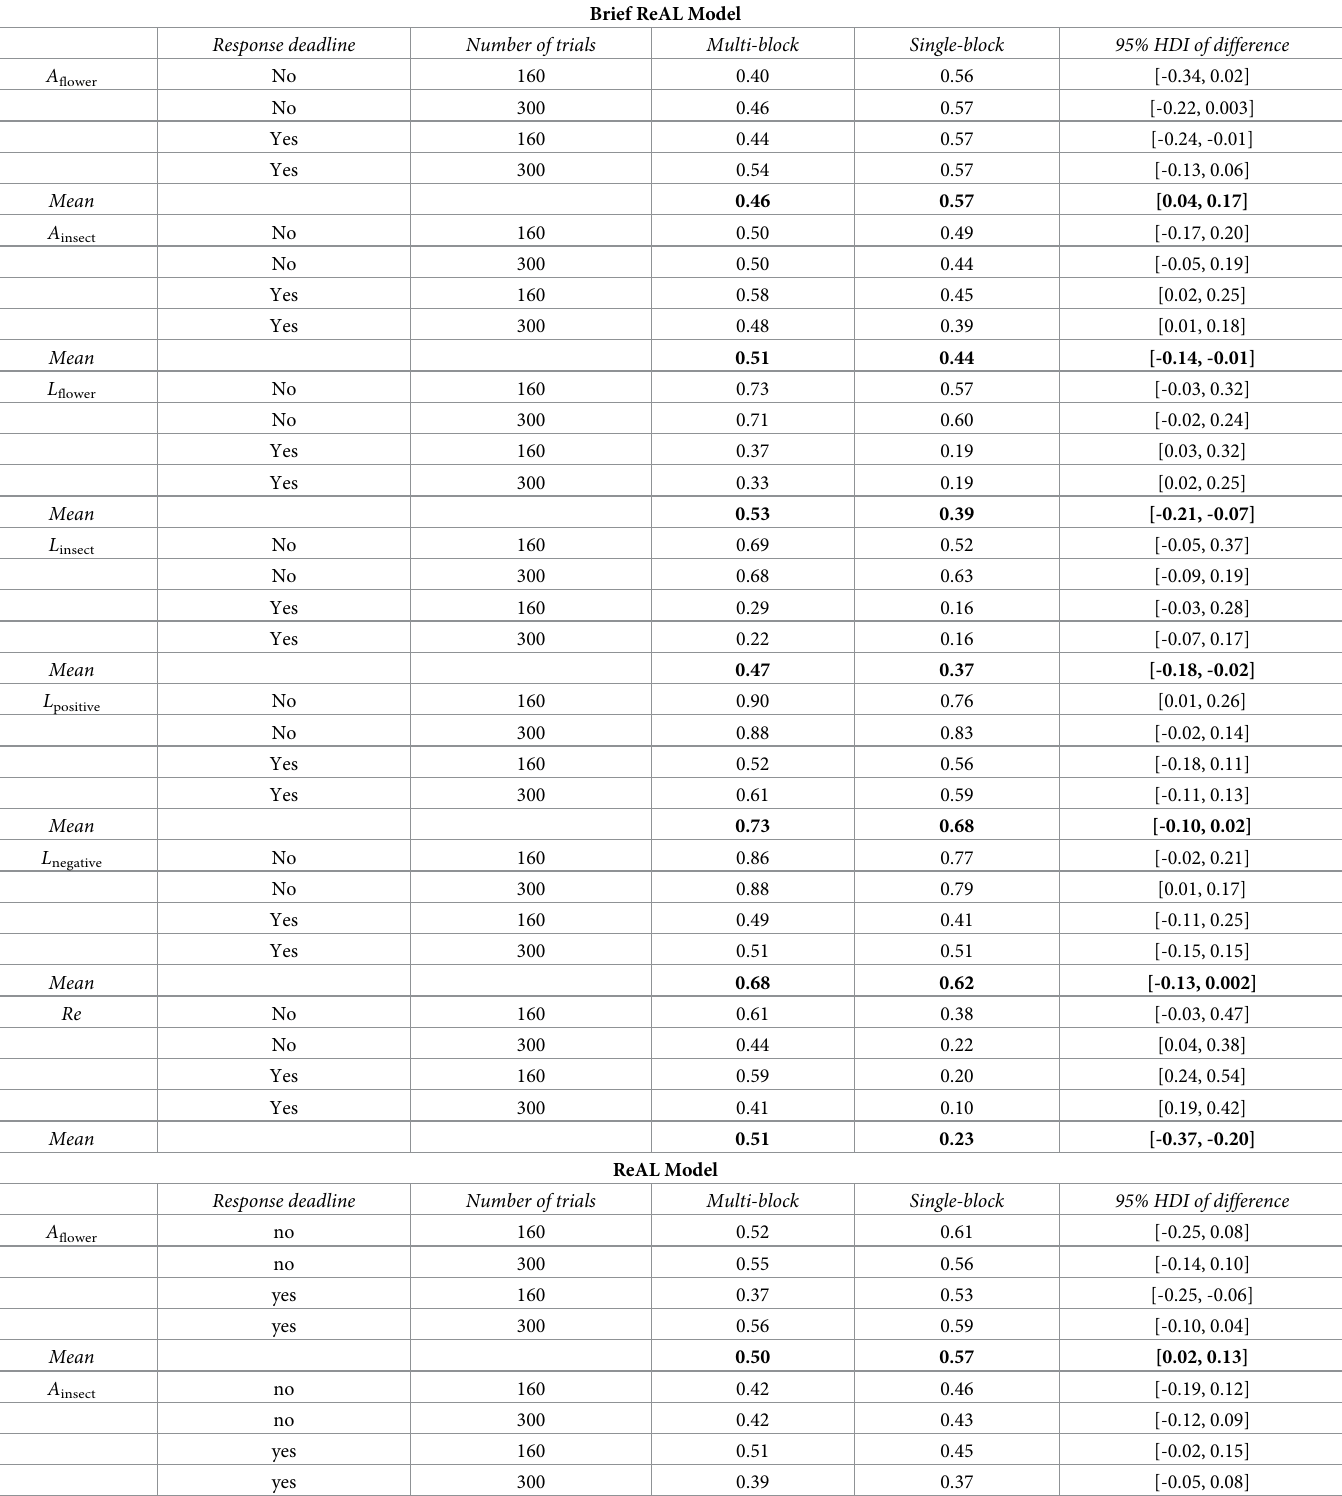
Table 6. Mean parameter estimates from multi-block versus single-block